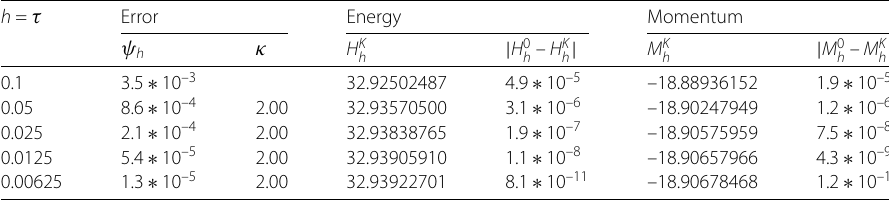
Table 1 Error, energy and momentum for Problem 1 using FDS-S